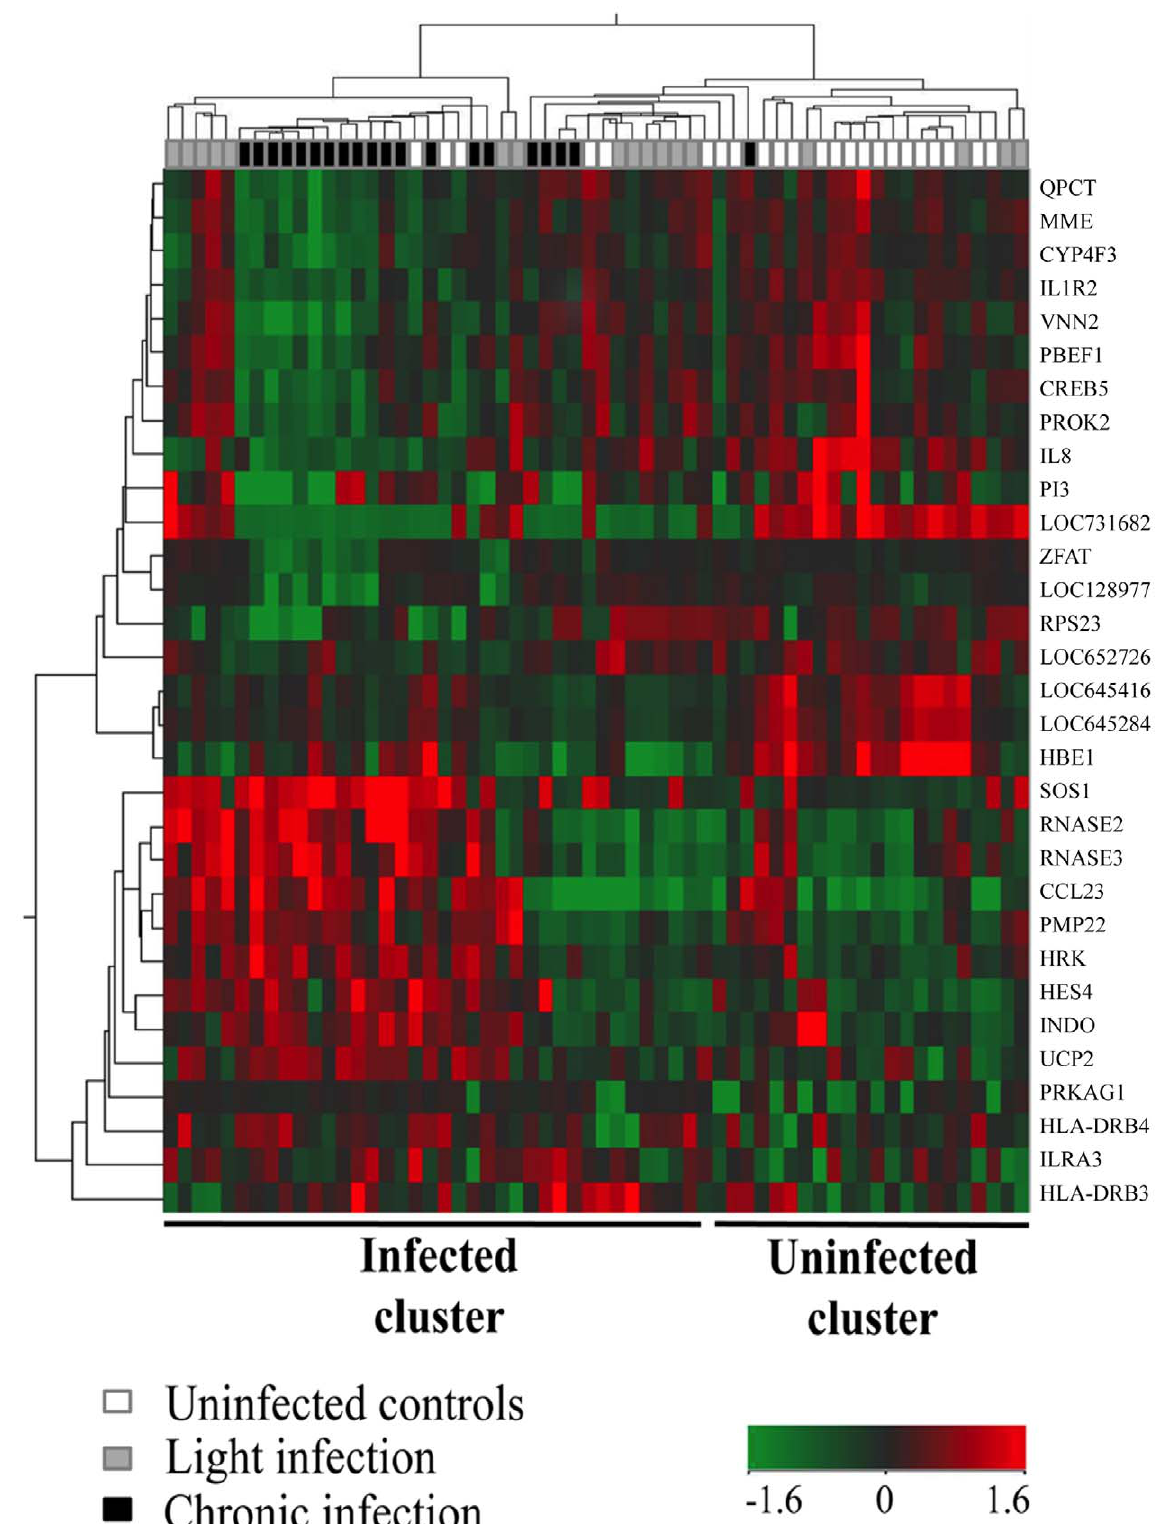
Figure 2. Heat map representing hierarchical clustering of gene expression for the 60 study children. Gene expression profiles are shown for uninfected children, and those with light and chronic infections. Red indicates increased gene expression and green decreased gene expression.